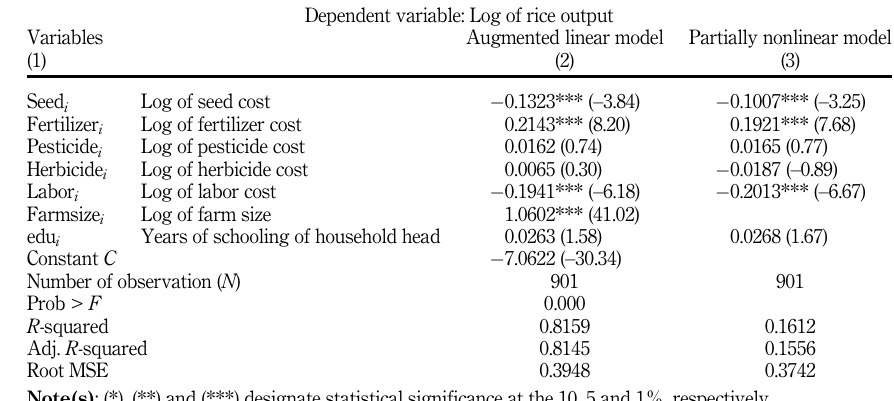
Table 4. Estimation results of constant coefficient